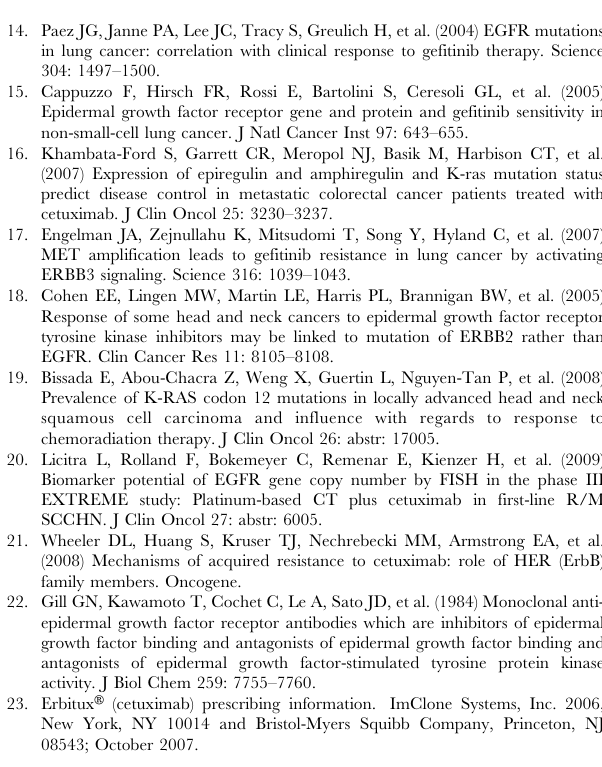
Table S2 900 probes that are differentially expressed between SCC1 and